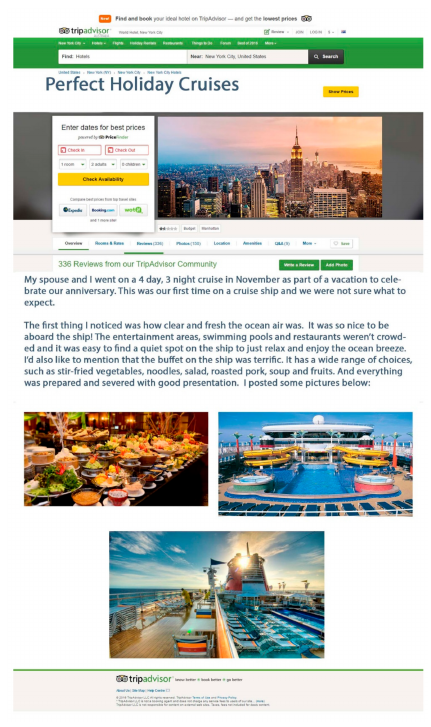
Figure A1. Cruise Ship, Positive Review, Positive Image.